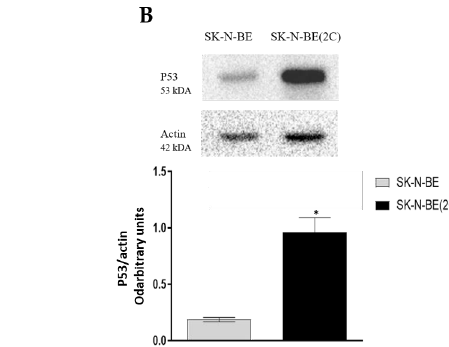
expression in SK-N-BE and SK-N-BE(2C) cells. For RT-PCR, 18S was used as a housekeeping gene; ( B )